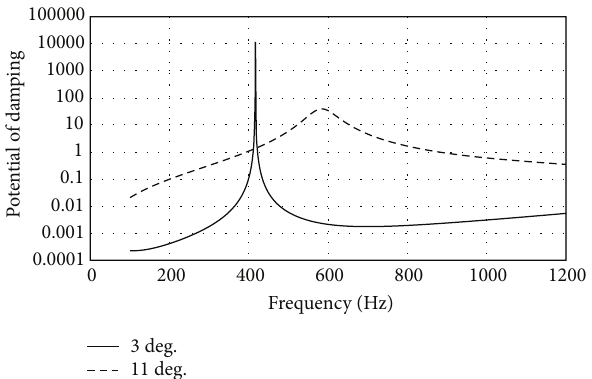
Figure 8: Damping potential for two particular sandwich-type CLD